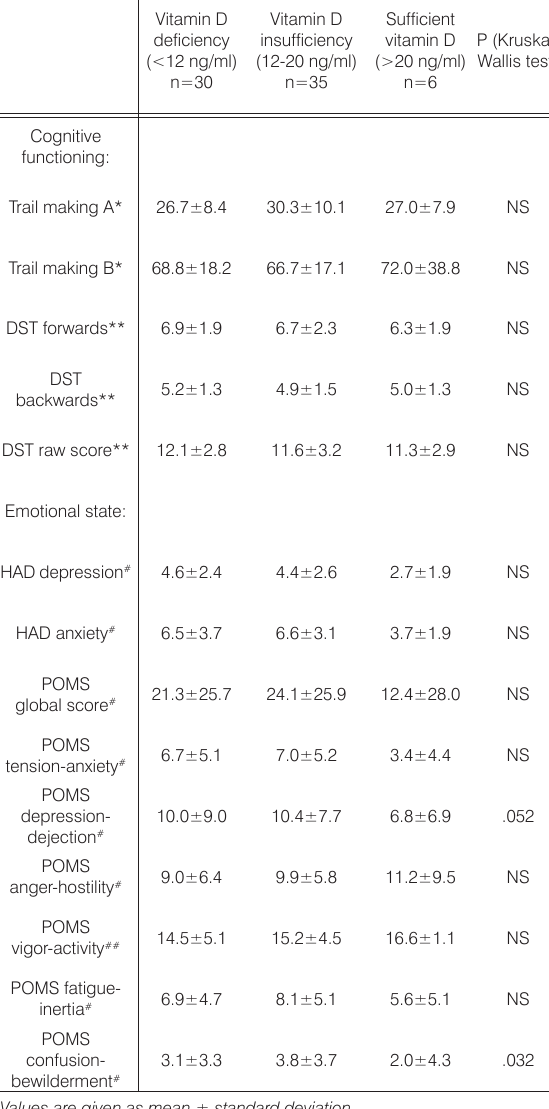
Table 7 Body composition in different subgroups of military conscripts by vitamin D